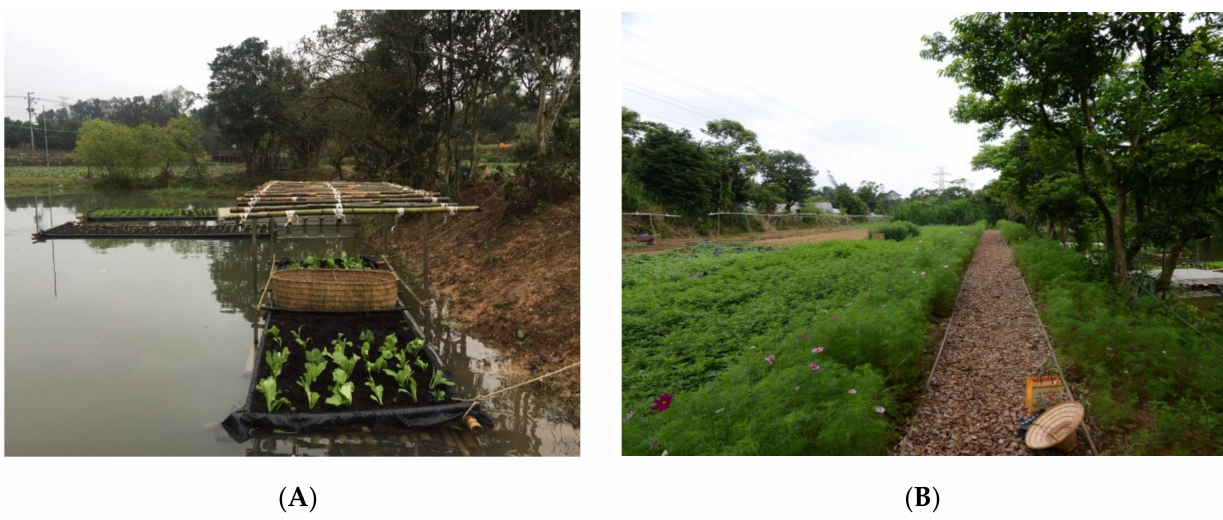
Figure 3. ( A ) Artificial floating islands located in ponds; ( B ) food farms situated in vacant